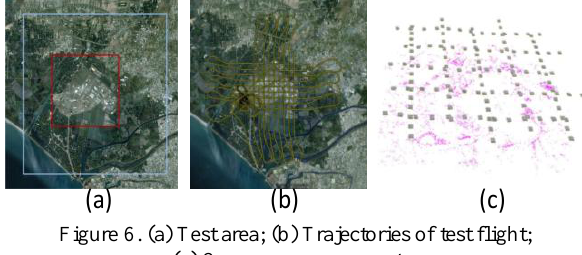
Figure 6. (a) Test area; (b) Trajectories of test